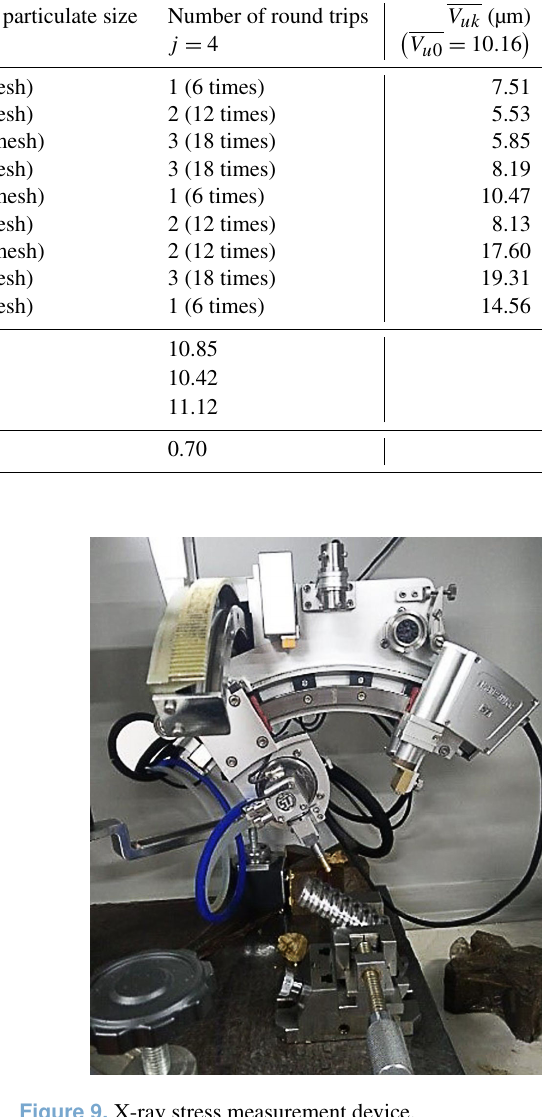
4), K 14 , K 24 and K 34 , are almost equal, of which K 24 is the than K 14 . In the last row of the table, R 1 is the biggest